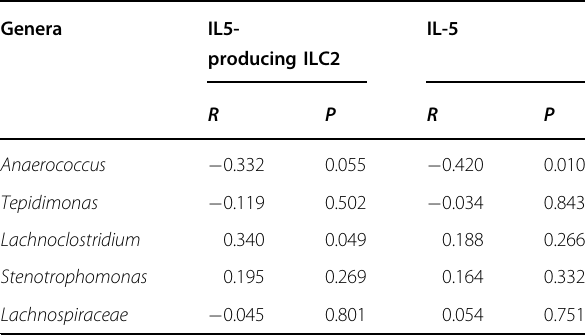
Table 2 Correlation between sinus bacteria and IL5- producing group 2 innate lymphoid cells (ILC2s) and IL-5 levels in sinonasal